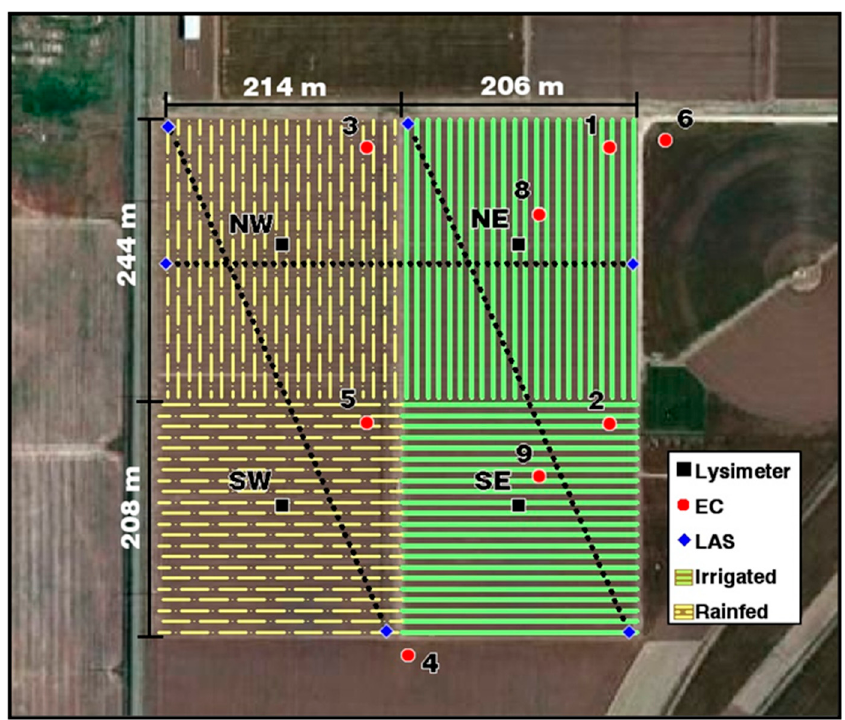
Figure 2. Experimental setup at the USDA-ARS, Conservation and Production Research Laboratory, Bushland, TX, with the positions of the eddy covariance systems (EC), large weighing lysimeters, and large aperture scintillometers (LAS), and their respective paths (dotted lines) shown. The orientation of the lines corresponds to the orientation of the rows. Table 1. Instrumentation details for the eddy covariance systems and lysimeter.